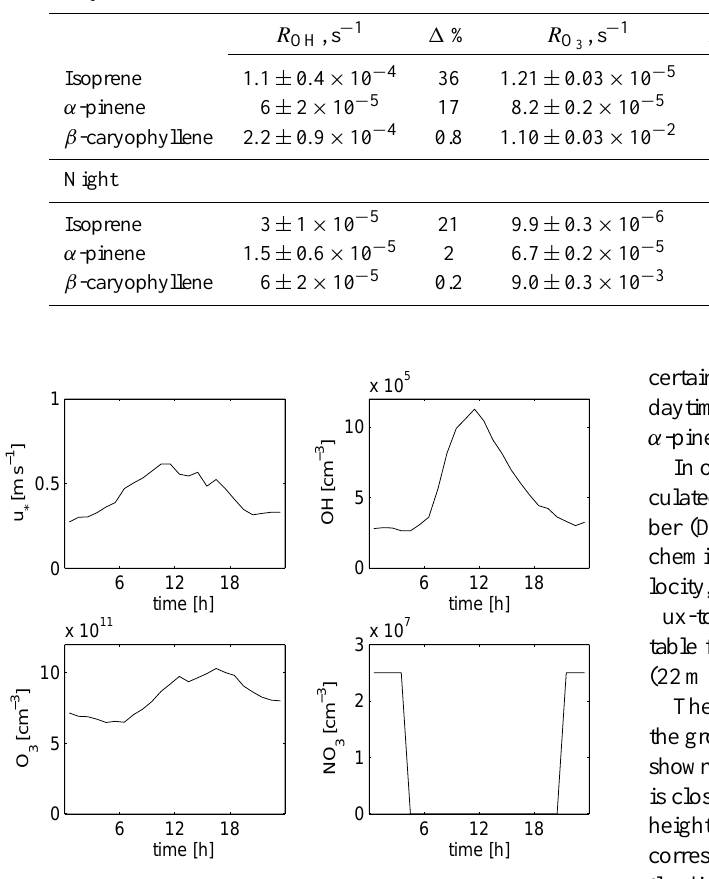
Fig. 7. Typical diurnal cycles of friction velocity, OH, O 3 , and NO 3 , as derived from measurements during HUMPPA-COPEC- 2010